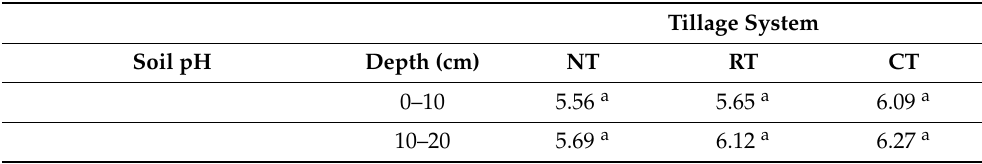
Table 2. Soil pH and SOC measured 17 years after implementation of the trial at different soil depth and under different tillage treatments (NT, CT, and